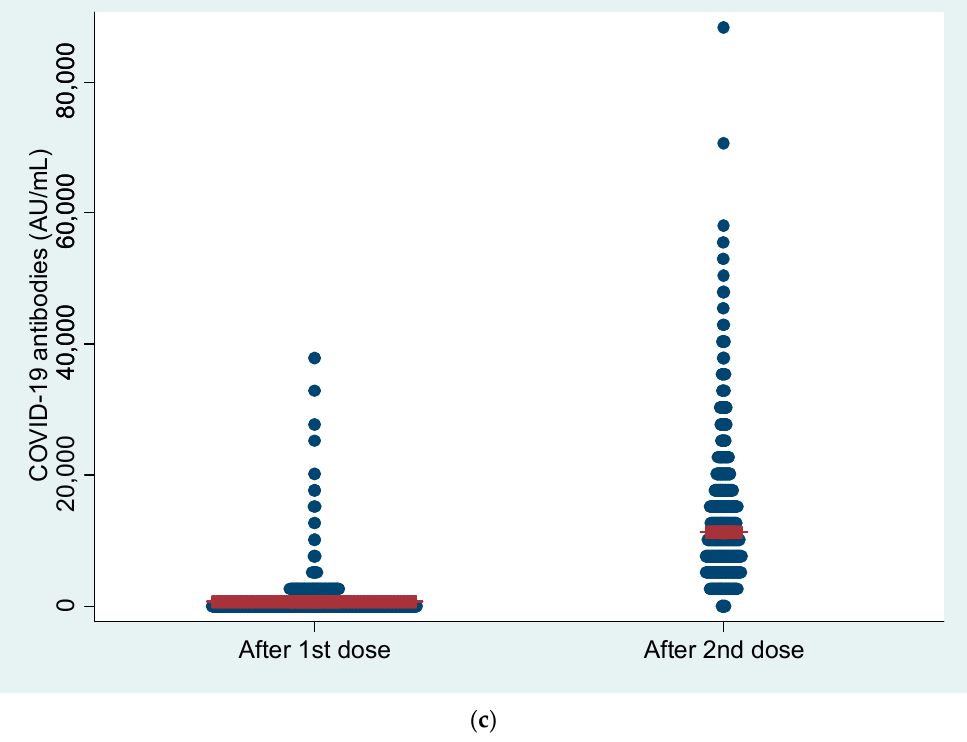
Table 2. Descriptive statistics for antibodies after the first and the second dose .